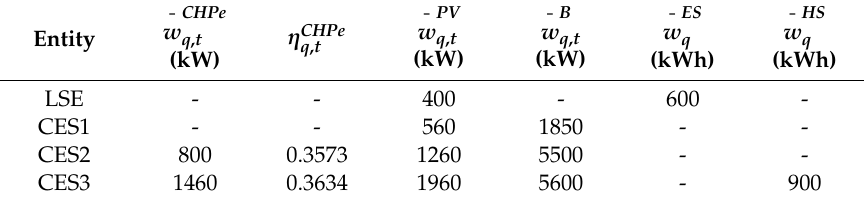
Table 1. Main operation parameters of LSE and CESs.